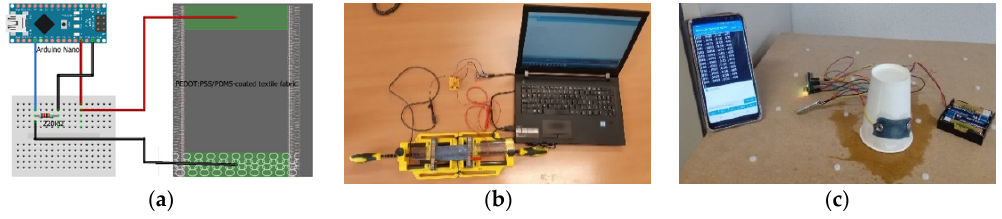
Figure 3. Dynamic tests: ( a ) Electrical circuitry establishment setup; ( b ) stretch; ( c )